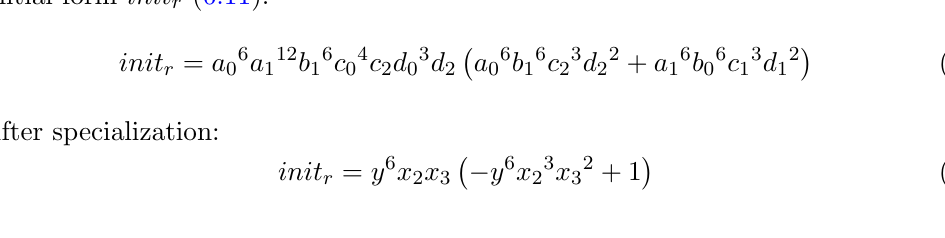
Figure 27 . Newton polygon and the initial form init r (red nodes) for diag(2 ; 3 ; 4) quiver. Initial form init r